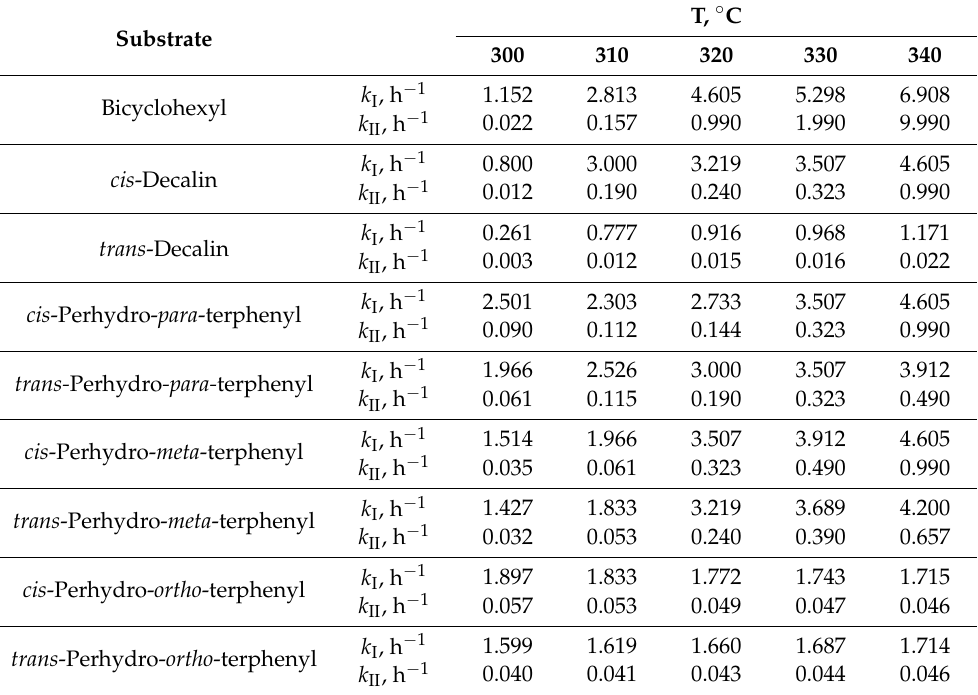
Table 4. Parameters for dehydrogenation of naphthenic substrates (LHSV = 1 h − 1 , P = 1 atm).